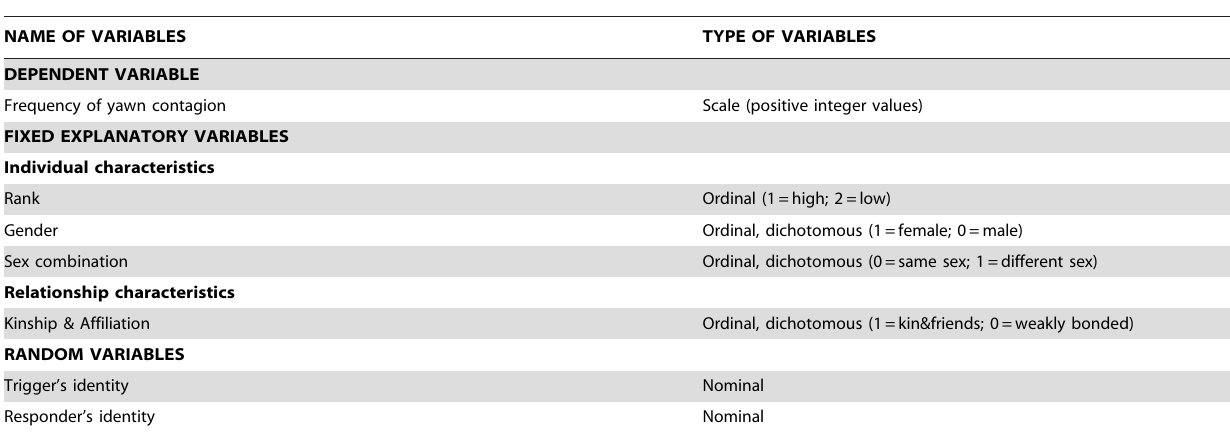
Table 1. Description of the variables used in LMM